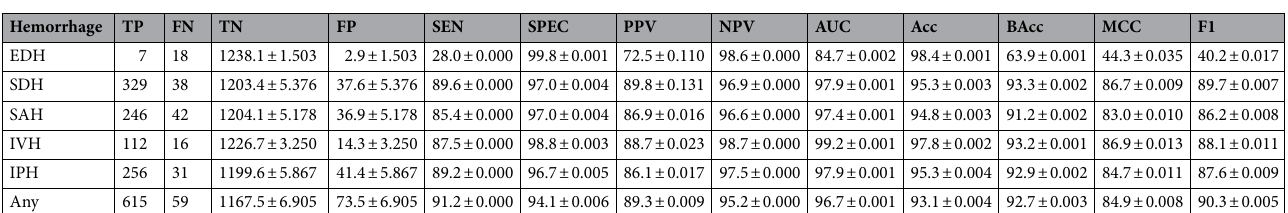
Table 4. ML performance in detecting ICH on the external validation set with a simulated equal prevalence as the test dataset. TP true positive, FN false negative, TN true negative, FP false positive, SEN sensitivity, SPEC specificity, PPV positive predictive value, NPV negative predictive value, AUC area under the receiver operating curve, Acc accuracy, BAcc balanced accuracy, MCC Matthews correlation coefficient, F1 F1 score. All the values except TP, FN, TN, and FP are in percent.